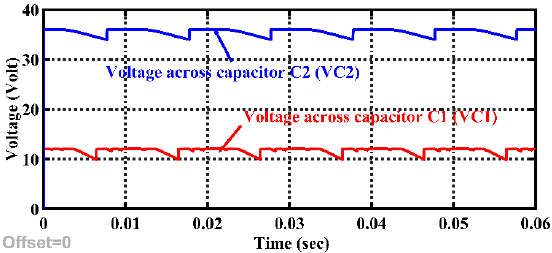
Figure 13. Voltage across capacitors C 1 and C 2 for asymmetric configuration.